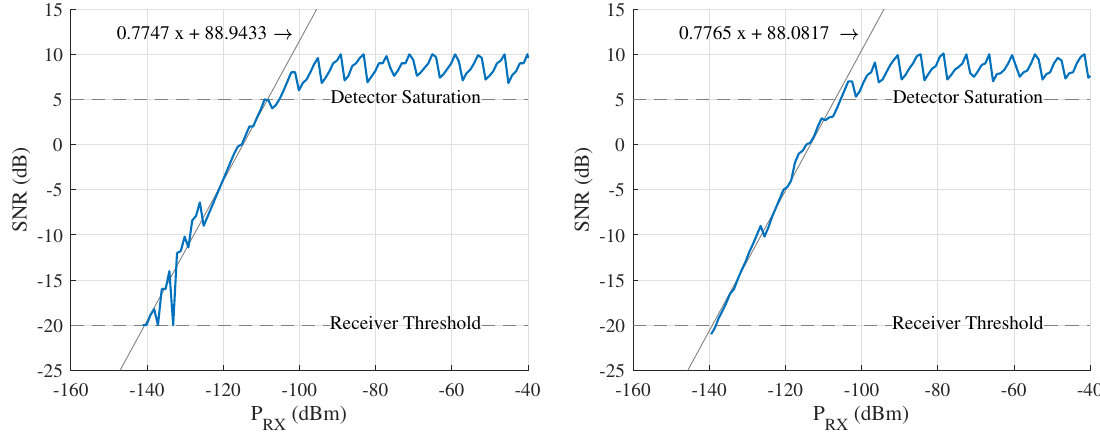
Figure 3. SNR measurement calibration for 434MHz ( left ) and 868MHz ( right